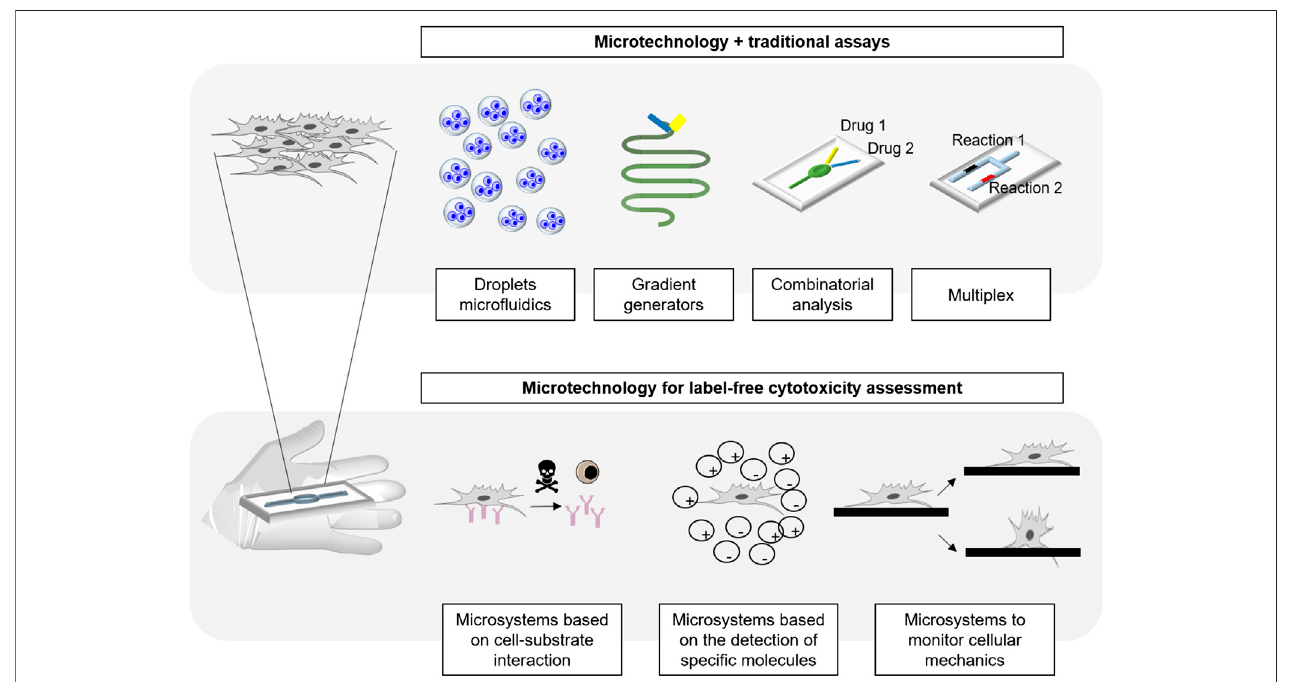
FIGURE 1 | Classi fi cation of microtechnology based cytotoxicity techniques in literature.